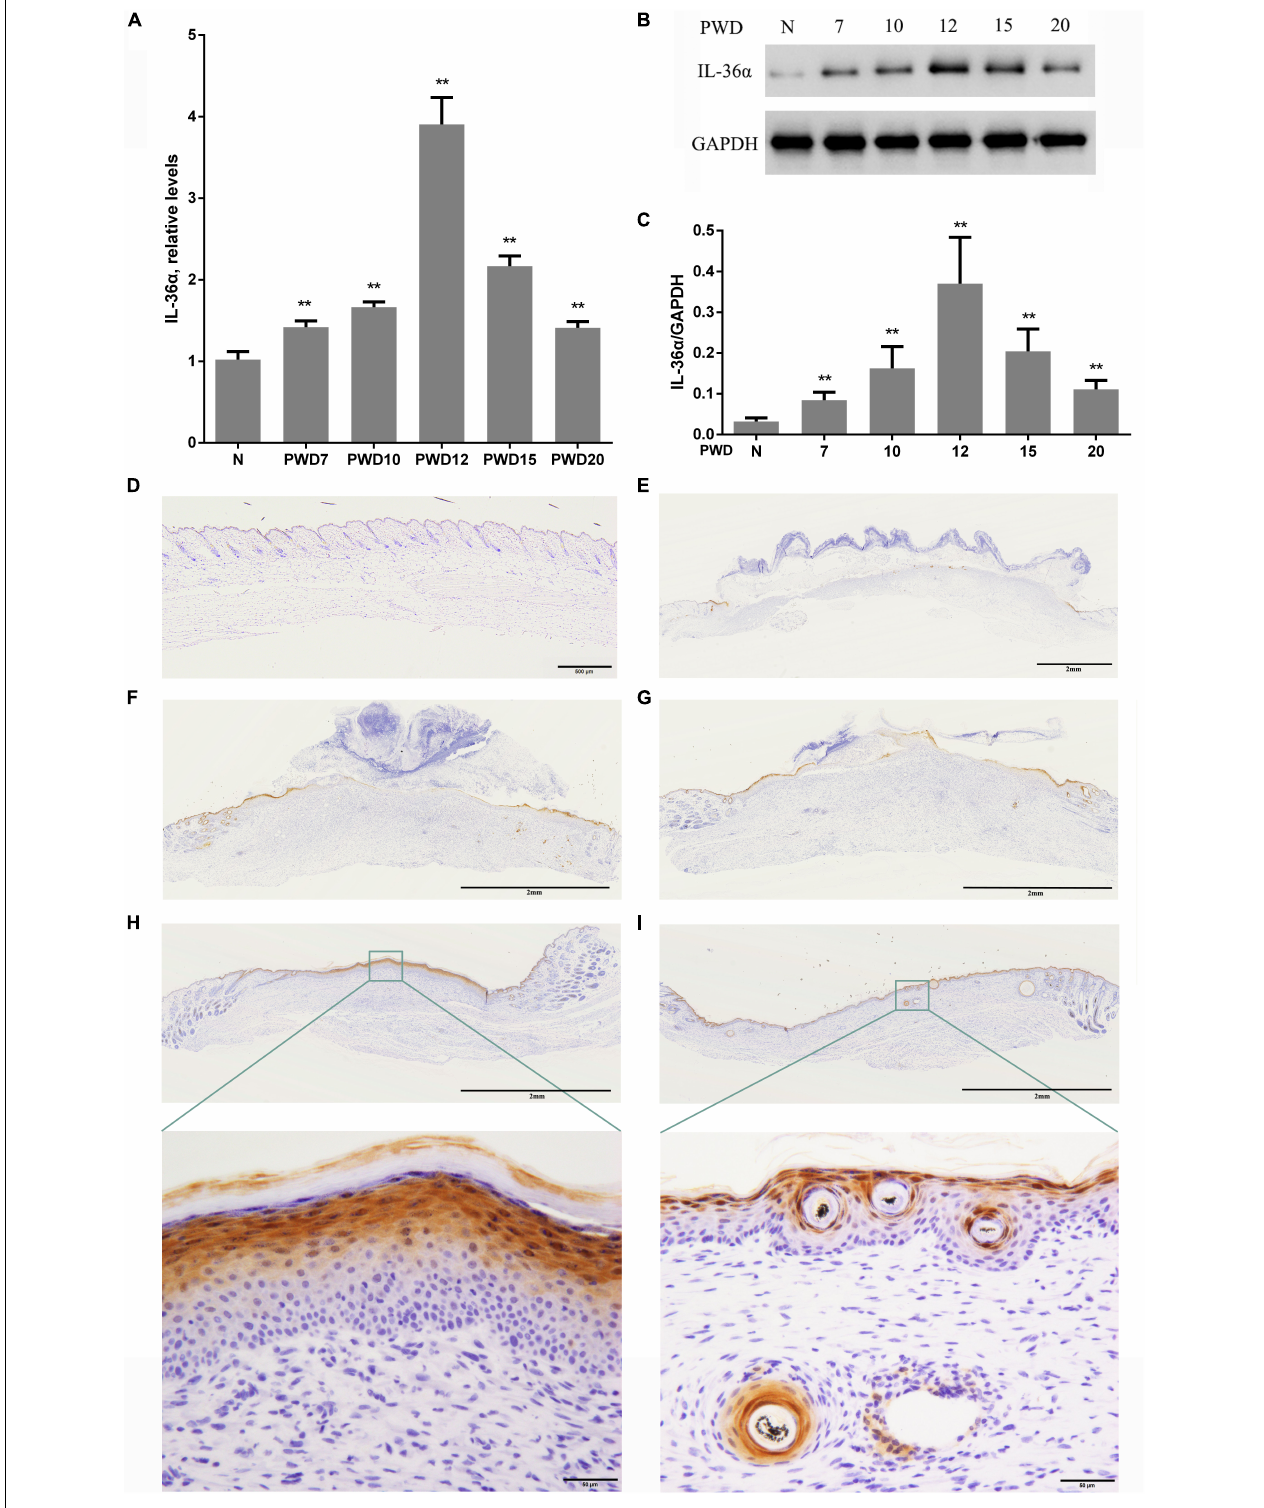
FIGURE 2 | Wound-induced spatiotemporal expression of IL-36 α . qPCR (A) and western blotting (B,C) for IL-36 α expression at the wound area from PWD 7–20 and normal mouse skin (control). (D–I) Immunohistochemistry of wounded and unwounded mouse skin paraffin sections to detect IL-36 α in the wound area and wound edge at PWD 0 (D) , 7 (E) , 10 (F) , 12 (G) , 15 (H) , and 20 (I) ( n = 5, ** p < 0.005, N, normal skin; PWD, post-wound day).